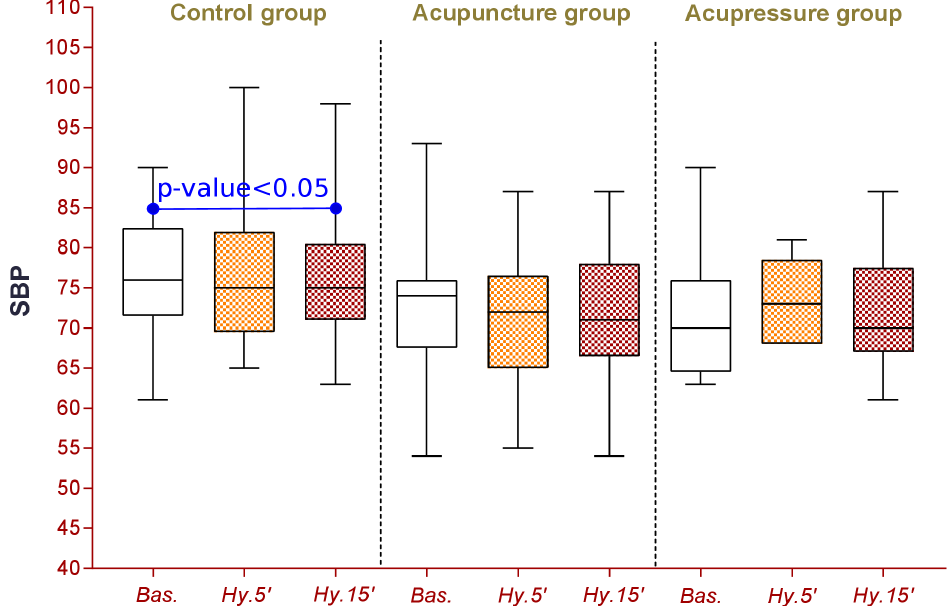
Figure 10. Descriptive analysis for millimeters of mercury systolic blood pressure (SBP) in control, acupuncture, and band (acupressure) groups at baseline and after 5 and 15 min of hypoxia.